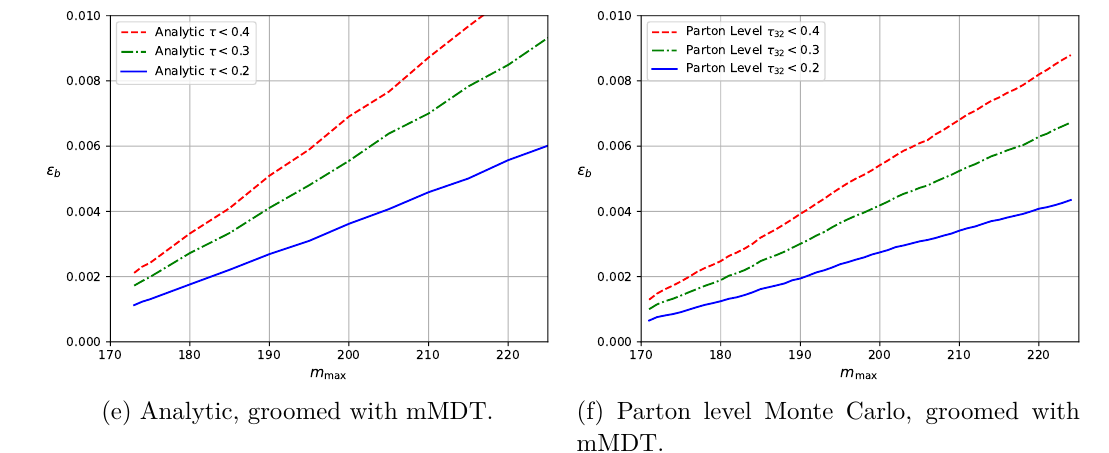
Figure 10. Analytic and Monte Carlo (parton level) curves showing how the background tagging rate varies with m max